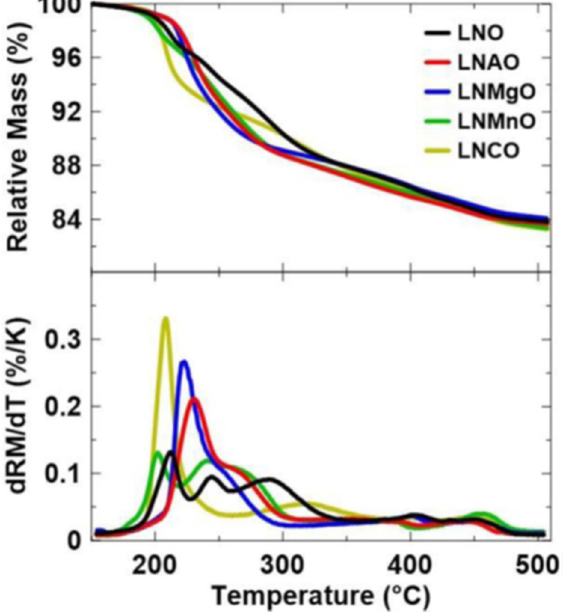
Figure 5. Thermal stability of LiNi x M 1-x O 2 by substituting the dopant Mn, Mg, Al, or Co in which x = 0 or 0.05 [51].